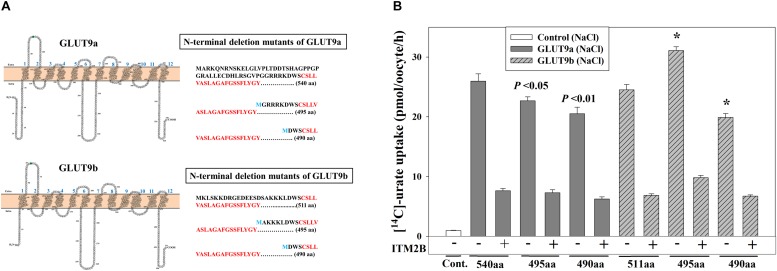
ITM2B inhibits the urate transport activity of N-terminal deletion mutants of GLUT9 isoforms. (A) Predicted membrane topology model of the isoforms of GLUT9 (GLUT9a and GLUT9b) with 12 hydrophobic transmembrane domains are shown at the left panels. The N-glycosylation site (confirmed by mutational analyses shown in Figure 4D) in the first extracellular loop was highlighted green. The amino acid (aa) sequences of the N-terminal cytoplasmic part of the GLUT9a/b (540/511 aa) and their respective N-terminal deletion mutants (495/490 aa) with starting amino acid M (marked blue) were shown at the right panels with the first transmembrane hydrophobic domains as marked bold red. (B) The [14C]-urate uptake activity of GLUT9a, GLUT9b, N-terminal deletion mutants of GLUT9a and GLUT9b, expressed alone or co-expressed with ITM2B in Xenopus oocytes, was measured in ND96 medium. Each oocyte was microinjected with 50 nl of cRNA solution containing 12.5 ng cRNA of GLUT9a/b or their respective N-terminal deletion mutants. For co-expression of GLUT9 or its mutants with ITM2B, each oocyte was microinjected with 50 nl of cRNA solution containing 12.5 ng of GLUT9a/b or their respective N-terminal deletion mutants and 12.5 ng of ITM2B cRNA. ∗P < 0.001 compared with the respective urate uptake mediated by GLUT9a(540aa) or GLUT9b(511aa).